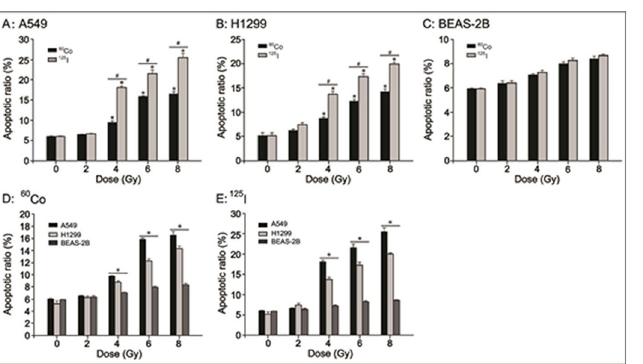
Fig 3. Apoptotic ratio of A549, H1299 and BEAS-2B cells irradiated with 125 I seeds CLDR radiation and 60 Co γ -ray HDR radiation. A-C: the difference in the apoptotic ratio of A549, H1299 and BEAS-2B cells receiving 125 I seeds CLDR radiation and 60 Co γ -ray HDR radiation. * indicates a significant difference (P < 0.05) when comparing 2, 4, 6 and 8 Gy irradiation by the two radiation sources and control (0 Gy) treatment, and # indicates a significant difference (P < 0.05) when comparing the two radiation treatments of the same doses. D, E: the difference in the apoptotic ratios of the three cell lines irradiated with 125 I seeds and 60 Co γ -rays. * indicates a significant difference (P < 0.05). Bars, standard error (SE).